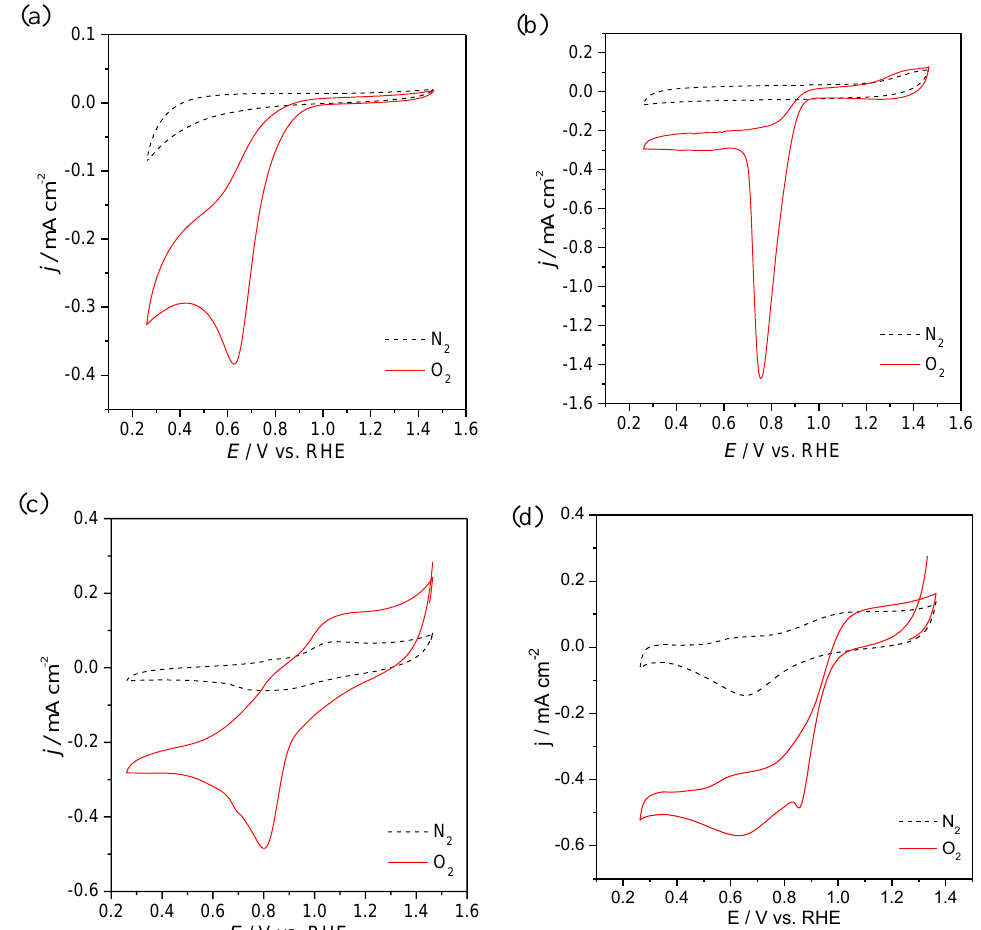
Figure 5. CVs in N 2 -saturated (dash line) and O 2 -saturated (full line) 0.1 mol dm − 3 KOH solution at 0.005 V s − 1 for S 3 N 2 –GF ( a ), Co / S 3 N 2 –GF ( b ), Mn / S 3 N 2 –GF ( c ) and commercial Pt / C (20wt%) modified electrodes ( d ).